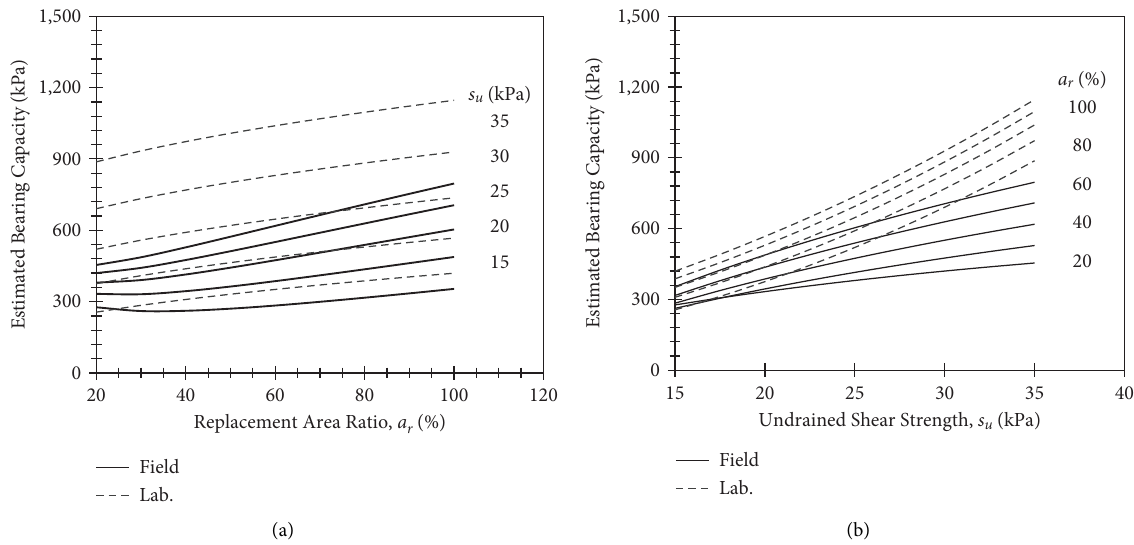
Figure 12: Change in ultimate bearing capacity of aggregate pier-reinforced clay according to (a) a